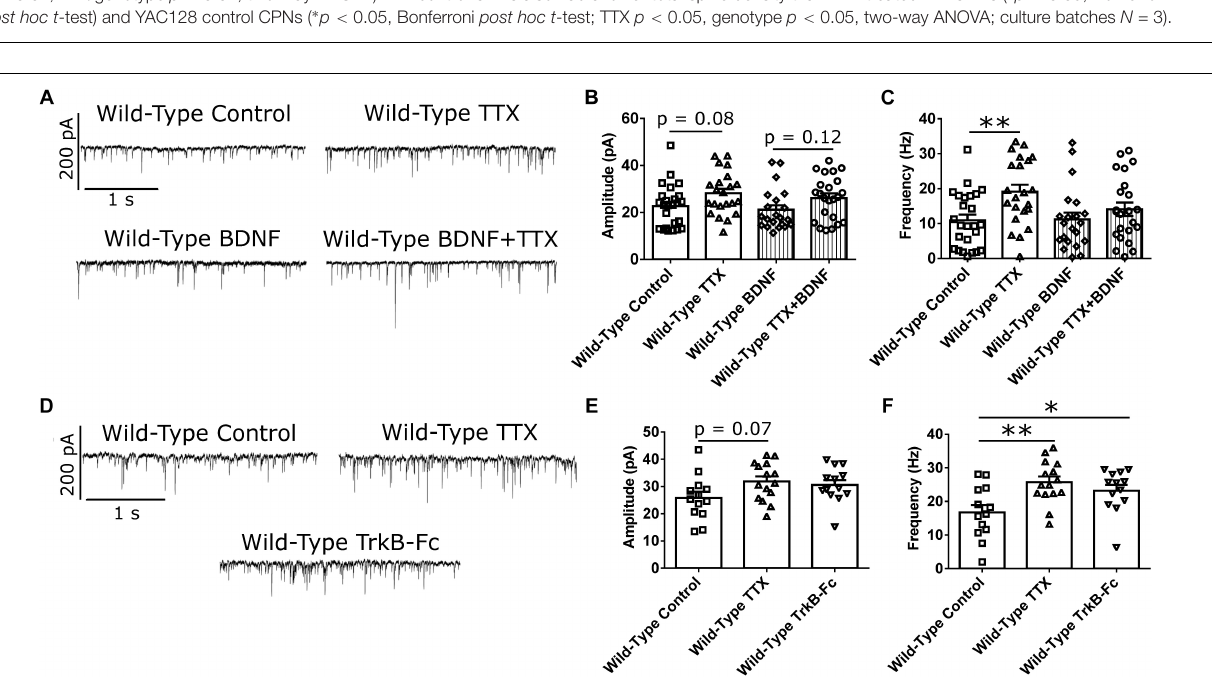
FIGURE 2 | Synaptic changes underlying homeostatic plasticity. (A) Representative images of CPNs filled with GFP (green), and stained for GluA2 (red), and VGLUT1 (blue). (B) Density of (i) GluA2 (genotype p < 0.01, two-way ANOVA), (ii) VGLUT1 (genotype p < 0.05, genotype/TTX interaction p < 0.05, two-way ANOVA), and (iii) colocalised GluA2 and VGLUT1 puncta (genotype p < 0.01, genotype/TTX interaction p < 0.05, two-way ANOVA) on CPN dendrites. YAC128 control CPNs had a higher density of all three types of puncta than WT control CPNs (GluA2 ∗ p < 0.05, Bonferroni post hoc t -test; VGLUT1 ∗∗ p < 0.01, Bonferroni post hoc t -test; colocalised ∗∗∗ p < 0.001, Bonferroni post hoc t -test). WT CPNs treated with TTX also showed a tendency to increased VGLUT1 density ( p = 0.08, Bonferroni post hoc t -test) and significantly increased density of colocalised GluA2 and VGLUT1 puncta ( ∗ p < 0.05, Bonferroni post hoc t -test) relative to WT control CPNs. YAC128 CPNs treated with TTX did not differ from either YAC128 control CPNs or WT CPNs treated with TTX ( p > 0.99, Bonferroni post hoc t -test; cells per group n = 24, culture batch N = 3). (C) Representative images of spines on CPNs filled with GFP. (D) Spine density, grouped by morphology. WT control CPNs had a higher density of mushroom spines than TTX-treated WT CPNs ( ∗ p < 0.05, Bonferroni post hoc t -test; genotype p < 0.05, two-way ANOVA), as well as fewer longneck mushroom spines (mushroom spines with necks > 1 µ m in length; ∗∗ p < 0.01, Bonferroni post hoc t -test) and filopodia/thin spines ( ∗∗∗ p < 0.001, Bonferroni post hoc t -test). Compared to YAC128 control CPNs, WT control CPNs also had fewer longneck mushroom spines ( ∗ p < 0.05, Bonferroni post hoc t -test; TTX p < 0.05, TTX/genotype interaction p < 0.01, two-way ANOVA) and filopodia/thin spines ( ∗∗∗ p < 0.001, Bonferroni post hoc t -test; TTX p < 0.01, genotype